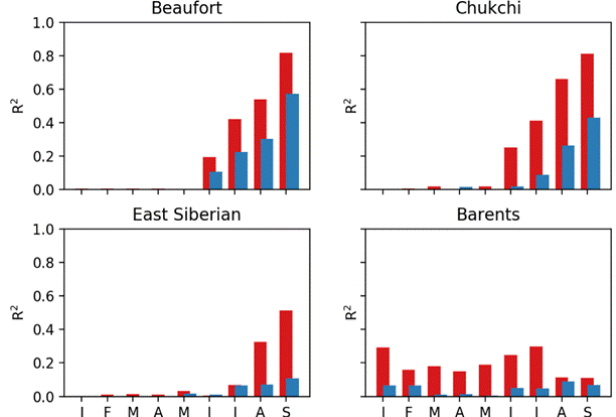
Figure 10. Examples of variances explained by correlations be- tween the Barnett Severity Index and regional ice extent in individ- ual calendar months from September back to January (BSI lagging by 0, 1, 2, ..., 8 months). Plotted values are squares of correlations (i.e., explained variances). Red bars are values with trends included, and blue bars are squared correlations after removal of trends. Sig- nificance thresholds as in Fig.